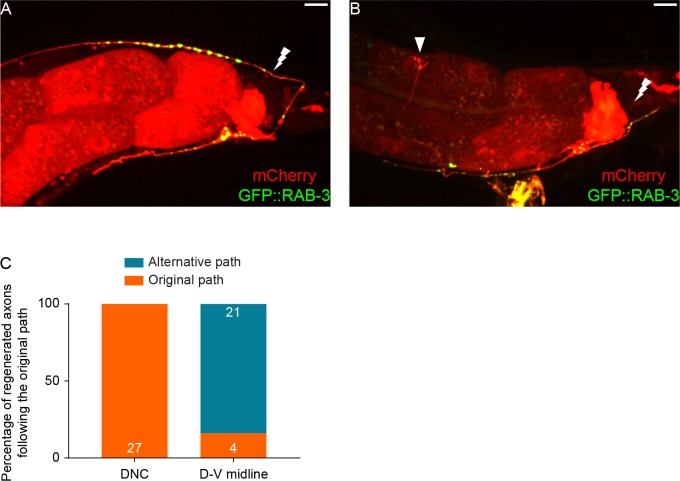
Axotomy in the DNC enables accurate axon growth following the original path.(A) DA9 regeneration 48 hr after axotomy in the DNC. The lightning mark indicates the cutting site. The scale bar = 10 μm. (B) DA9 regeneration 48 hr after axotomy in the dorsal-ventral midline of the commissure. The lightning mark indicates the cutting site. The arrowhead indicates the growth cone. The scale bar = 10 μm. (C) Quantification of regenerated DA9 axons following the original axon path or an alternative path. The number indicates number of animals.